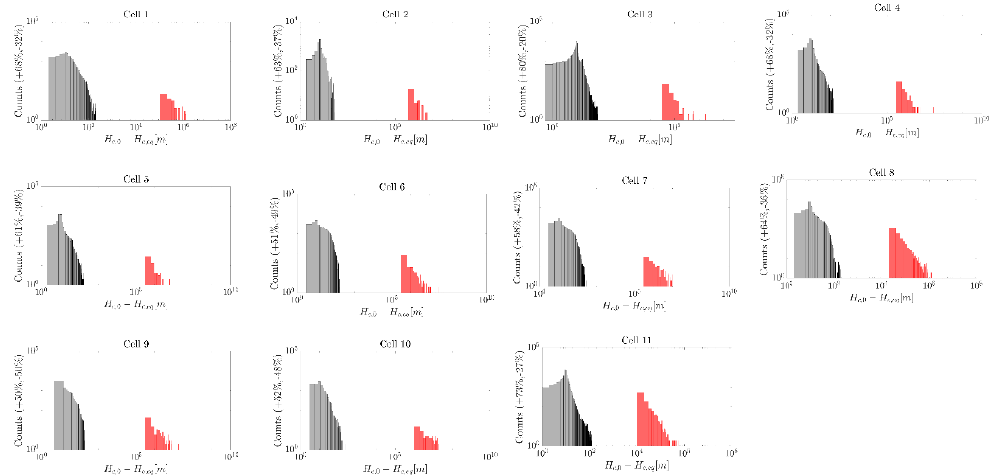
Figure 18. Regional statistics of 𝐻 𝑐,0 − 𝐻 𝑐,∞ along GB coastline. To obtain these stats, we did not include clusters that corresponded with non-cliff coastlines (Clusters 1, 5 and 8) and 4% of other clusters that had 𝐻 𝑐,0 < 0 and 𝑆 0 ≥ 0 . We used Equation (8b) and assumed a shoreface slope representative of GB’s open coast to be equal to 10 -2 . Grey bins represent section counts where 𝐻 𝑐,0 − 𝐻 𝑐,∞ > 0 (i.e., potential sediment sources), and red bins represent section counts for which 𝐻 𝑐,0 − 𝐻 𝑐,∞ < 0 (i.e., potential sediment sinks).